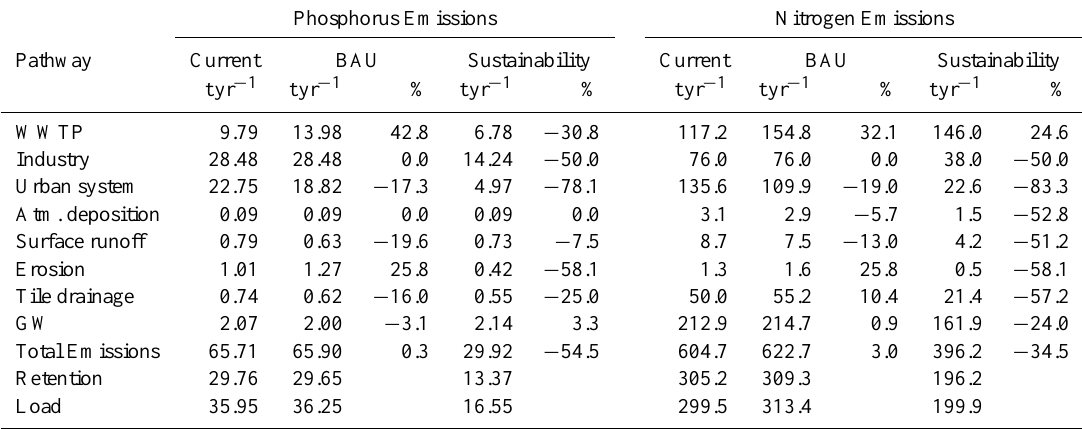
Table 4. Contribution of different sources to the emissions of phosphorus and nitrogen into the river basin in tonnesyr − 1 for the “BAU” and “Sustainability” scenarios, compared to the “Current” scenario. The changes in percentage are calculated based on the “Current”